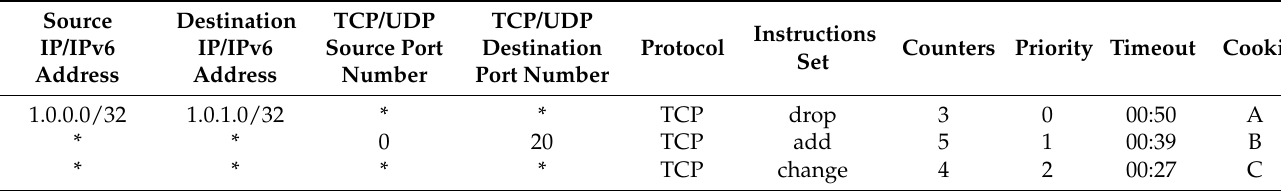
Table 1. This is a simple example of rule set, where * represents a null value.